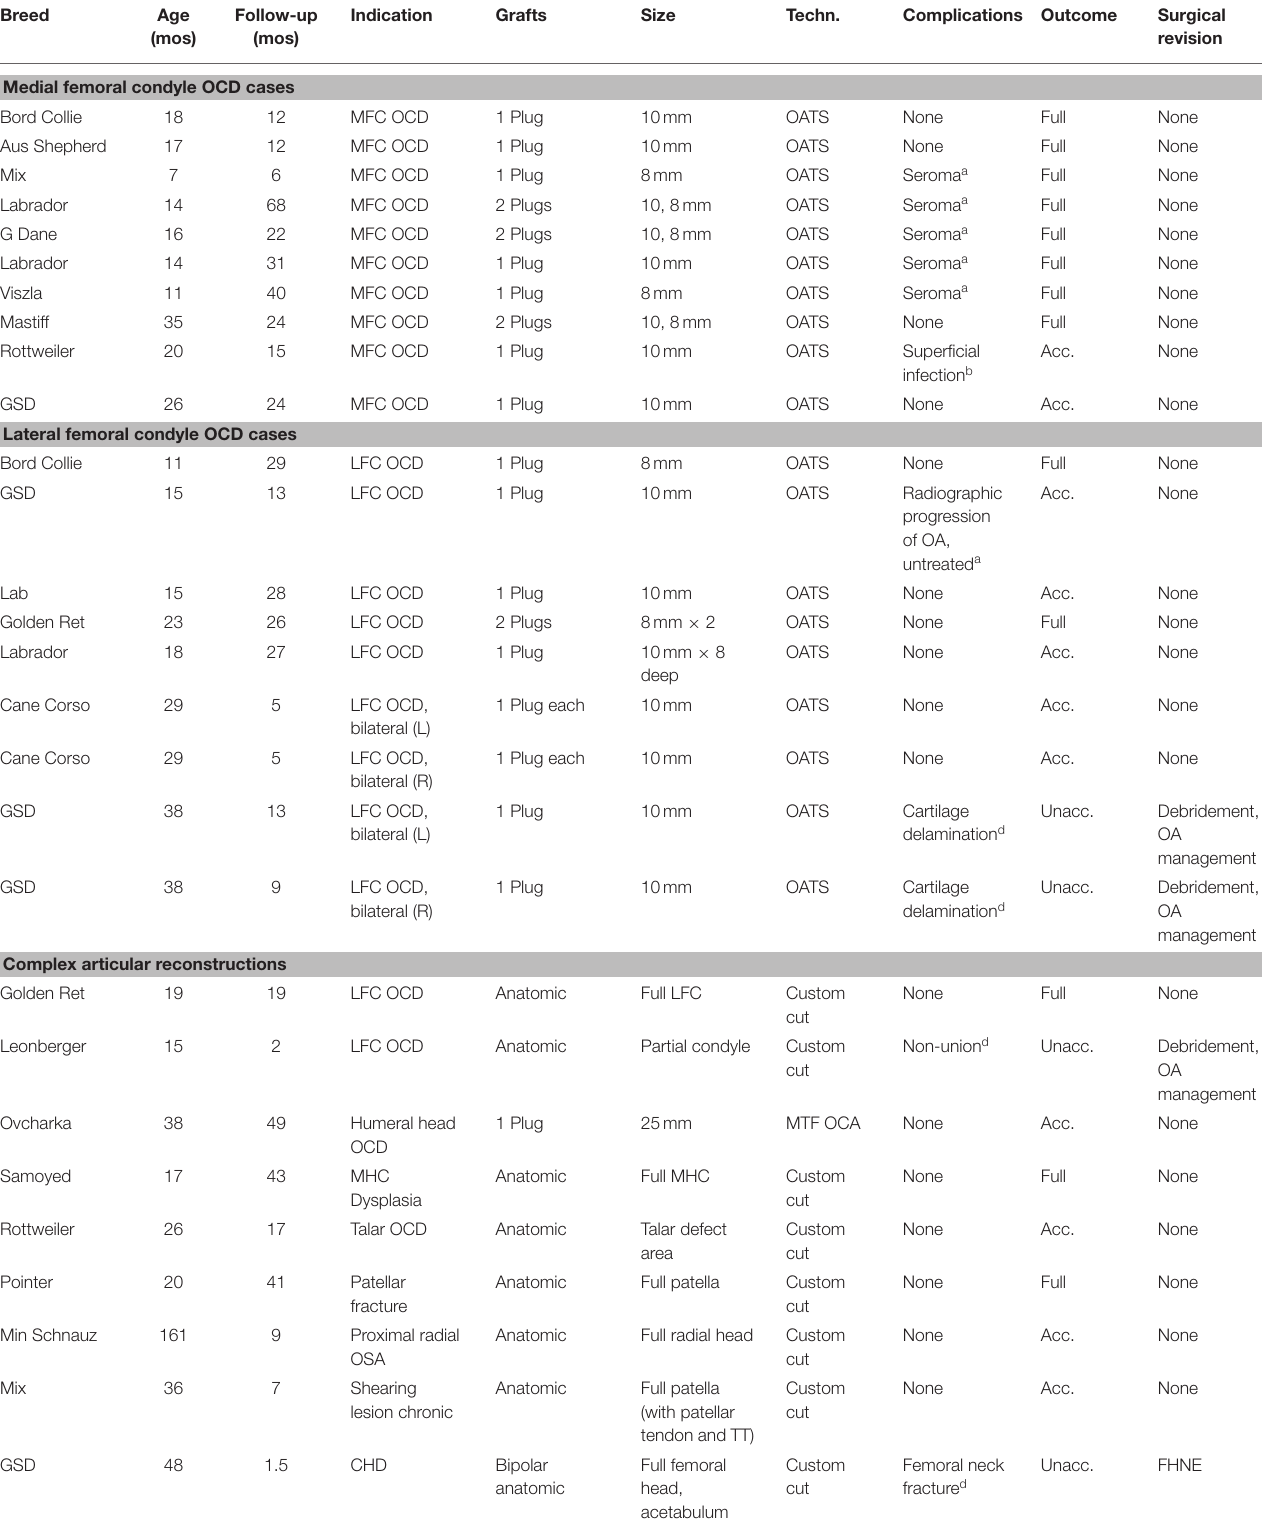
TABLE 1 | List of all cases treated with osteochondral allograft transfer. Breed Age Follow-up Indication Grafts Size (mos) (mos)